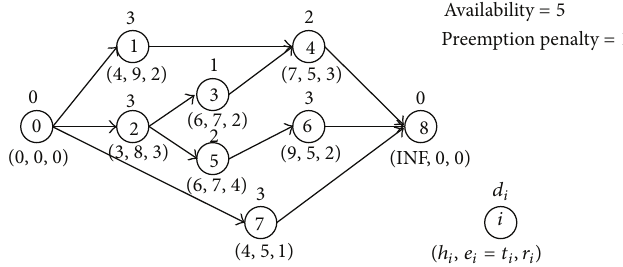
Figure 1: Problem instance for the PRCPSP-WETPP.